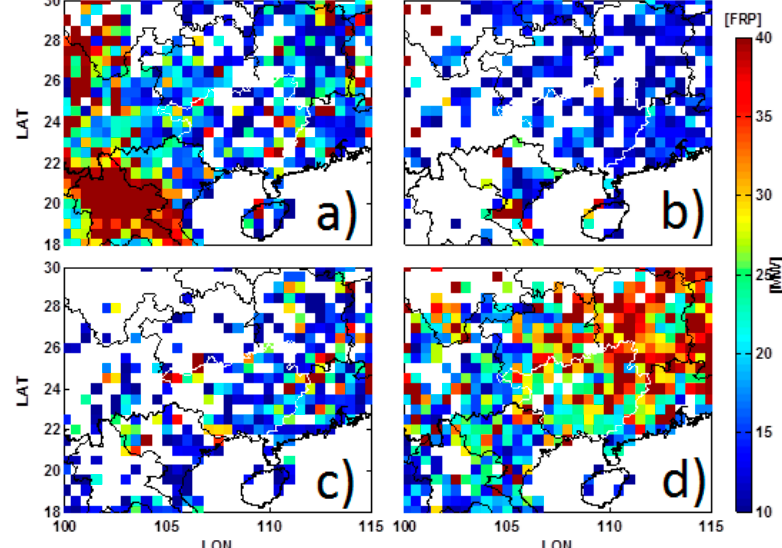
Figure 15. Spatial distribution of Fire radiative power in 2014 based on MODIS. ( a ) April; ( b ) July; ( c ) October; ( d ) January.